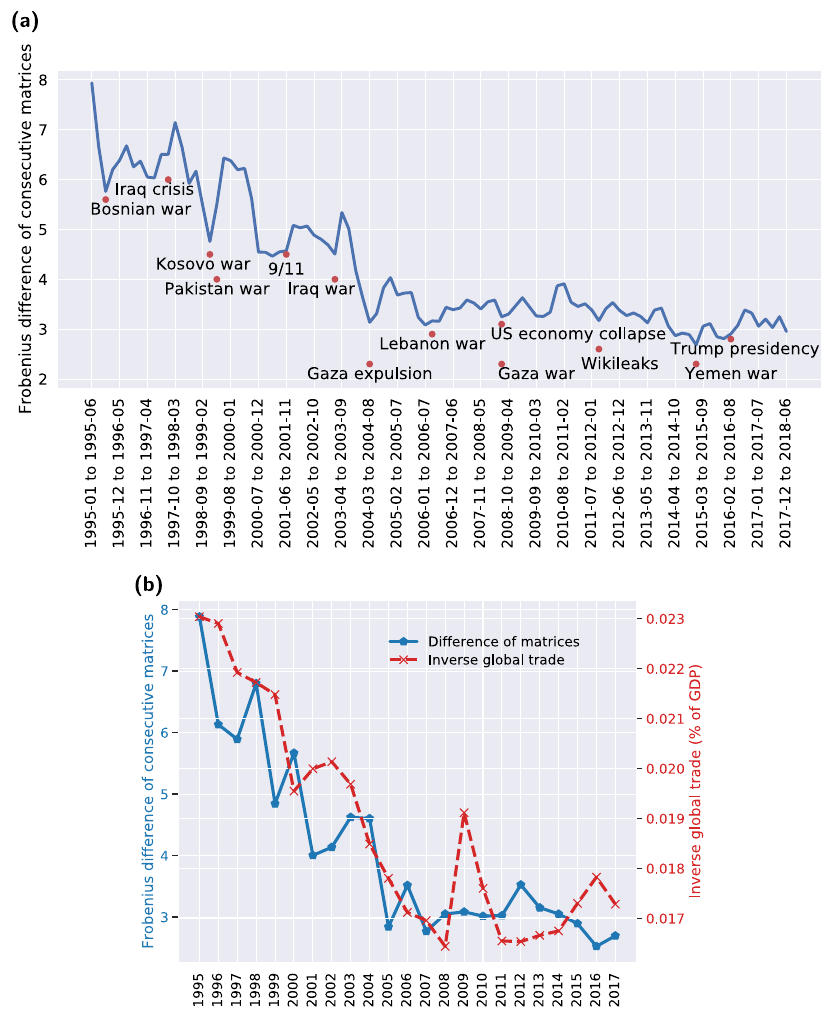
Fig. 6 International relationship stabilization. a The Frobenius norm difference of consecutive empirical transition matrices (blue line) becomes stable over time corresponding to the Markov chain of triads becoming stable over time. Most global exogenous events (red dots) such as wars trigger disturbances in the dynamics of relationships. b Comparison of the Frobenius norm difference of consecutive empirical transition matrices (full blue line), versus international trades in % of each country ’ s GDP (dashed red line) highlights a reverse relation between changes in the system and international trades. We fi nd Frobenius norm difference of consecutive empirical transition matrices and international trades are statistically and negatively correlated (Pearson ’ coef fi cients r = − 0.88 and p < 1e − 07). Moreover, we found that the international trades statistically Granger cause (49) the stability of relationships among countries ( p < 1e − 03). This result means the more international trades existed, the less changes in the relationships among countries have happened. Aligned with this fi nding, earlier research (6, 45 – 48) also claimed increased trades have decreased countries ’ incentive to attack each other, leading to a stable and network of alliances. Statistical signi fi cance is computed using n = 23 years of global trades and Frobenius norm difference of transition